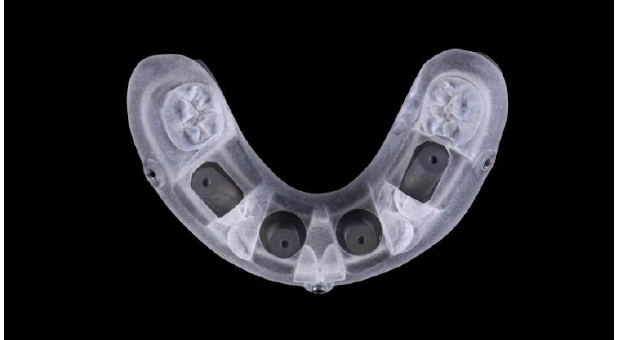
Figure 6. Computer-aided design of the prosthetic template for the six-implant impression.